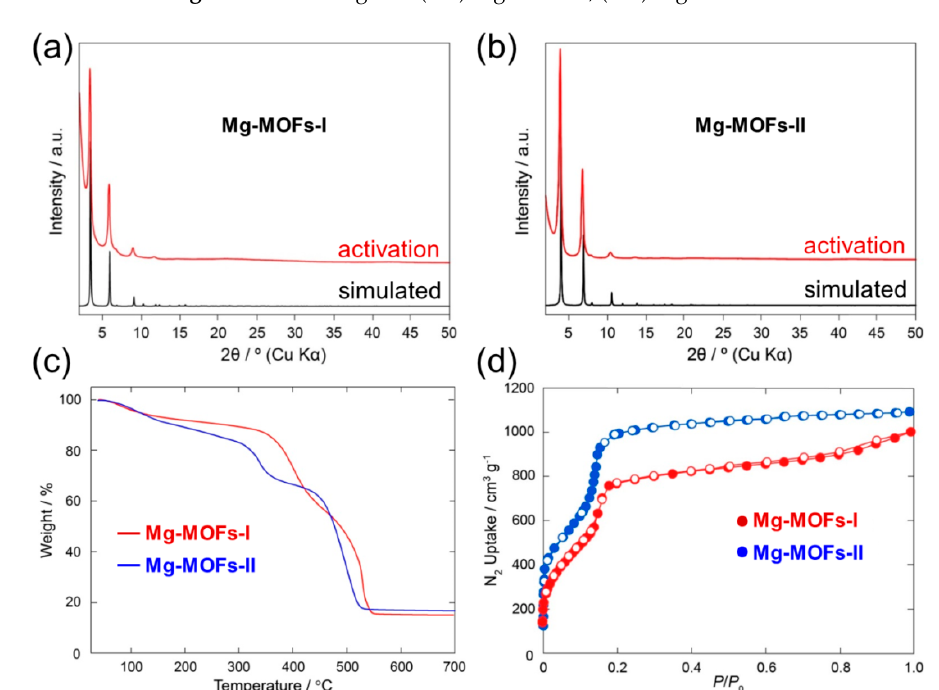
Figure 4. ( a ) XRD patterns of activated (red) Mg-MOFs-I and ( b ) activated Mg-MOFs-II samples (simulated patterns (black) generated from the structural model are provided as a reference). ( c ) TGA curves of (red) activated Mg-MOFs-I (blue) activated Mg-MOFs-II. ( d ) N 2 isotherms of (red) Mg-MOFs-I and (blue) Mg-MOFs-II at 77 K. The filled and opened symbols represent the adsorption and desorption processes, respectively.